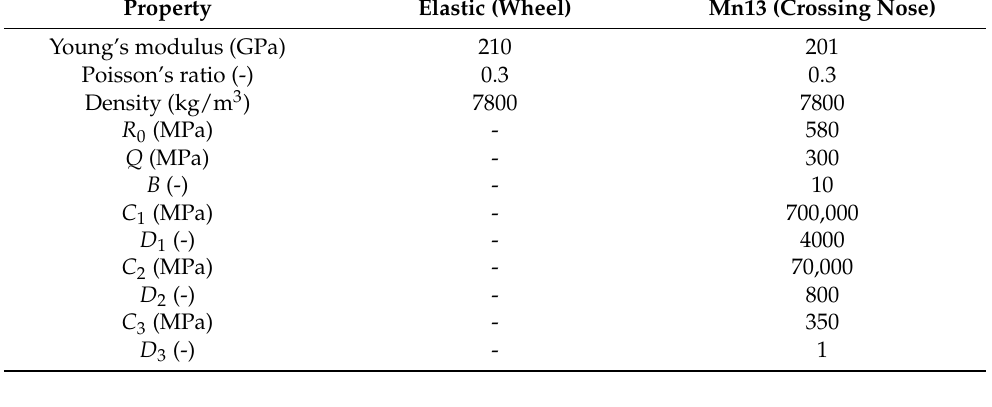
Table 1. Material parameters used in the FEA for the wheel and crossing nose part. The hardening parameters for Mn13 are calibrated from multiaxial low cycle fatigue tests with as-cast material.